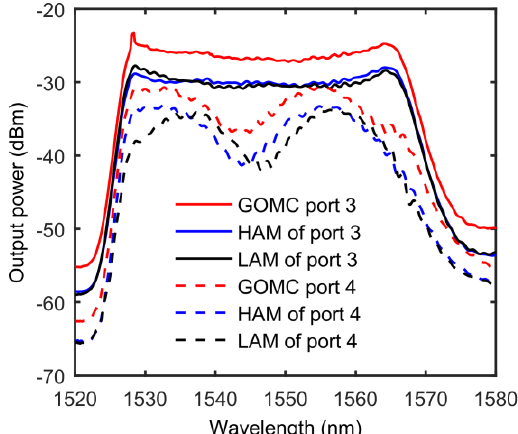
Figure 3. The schematic diagram of the GOMC transmission characteristic test system. CW: 980-nm Continuous Wave, OSA: Optical Spectrum Analyzer, PC: Polarization Controller.